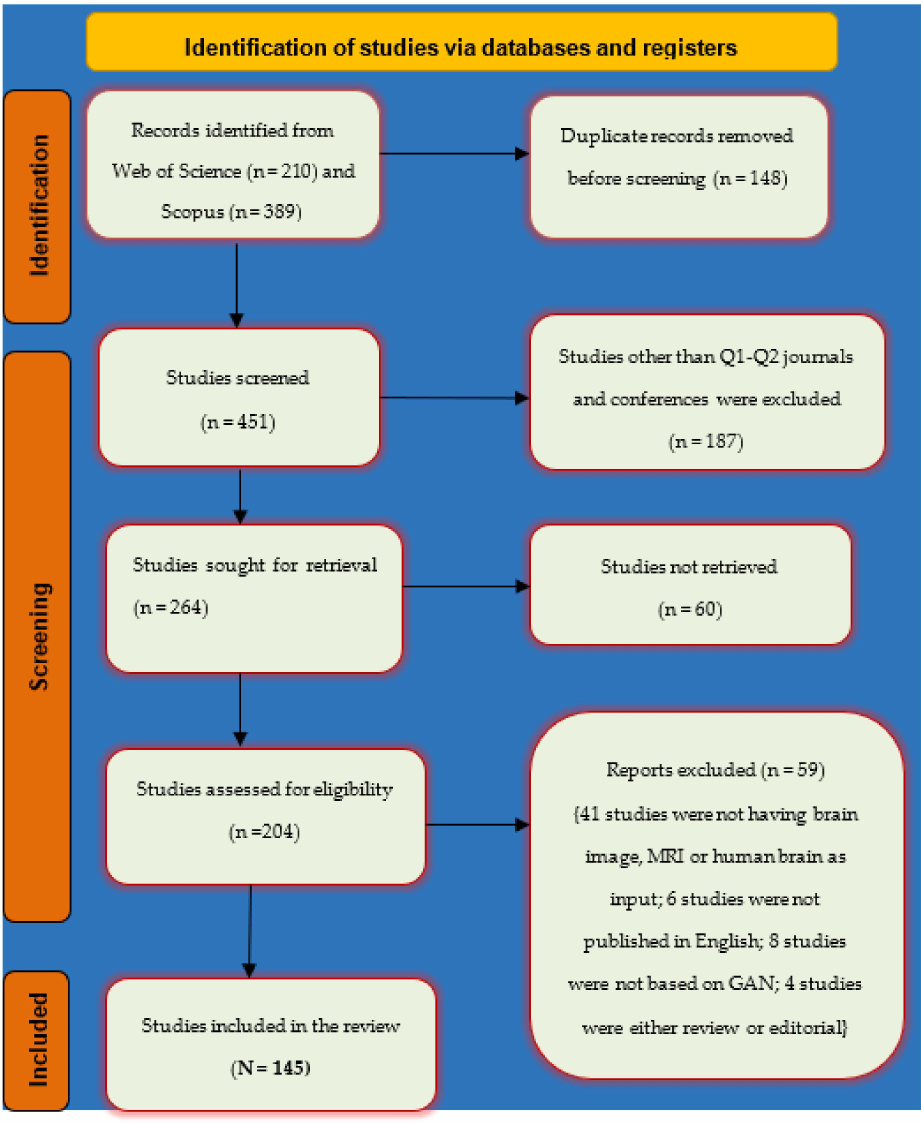
Figure 3. Flow diagram of the retrieval and selection